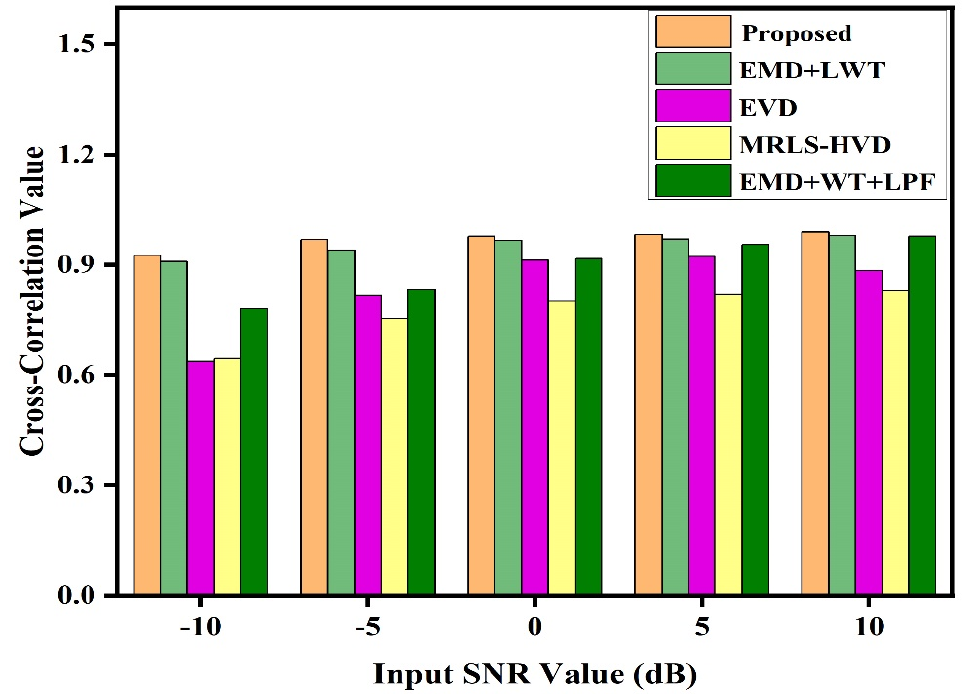
Figure 15. Comparison between the proposed method and various other methods in terms of average cross-correlation values between the clean input and denoised output signals in presence of 60 Hz PLI and baseline wander.